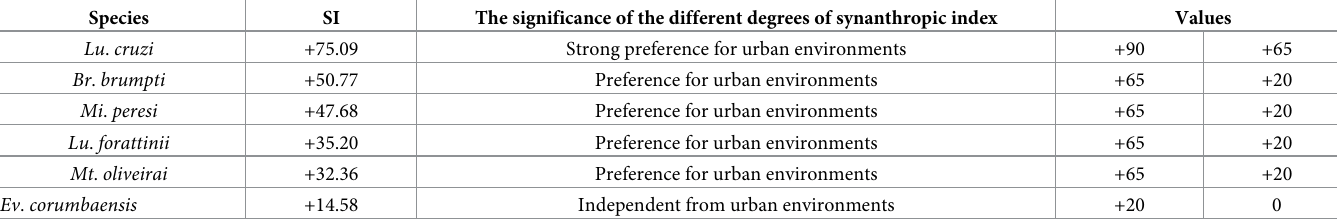
Table 3. Synanthropic index for male and female sand flies ( n > 10) in three areas (forested, rural, urban). Corumba´, Mato Grosso do Sul, Brazil. May 2015 to April 2017. Species SI The significance of the different degrees of synanthropic index Values +75.09 Strong preference for urban environments